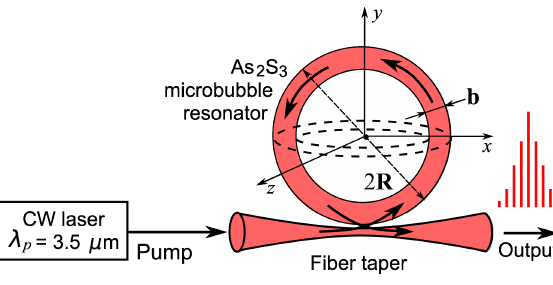
Figure 1. Scheme of the considered system.